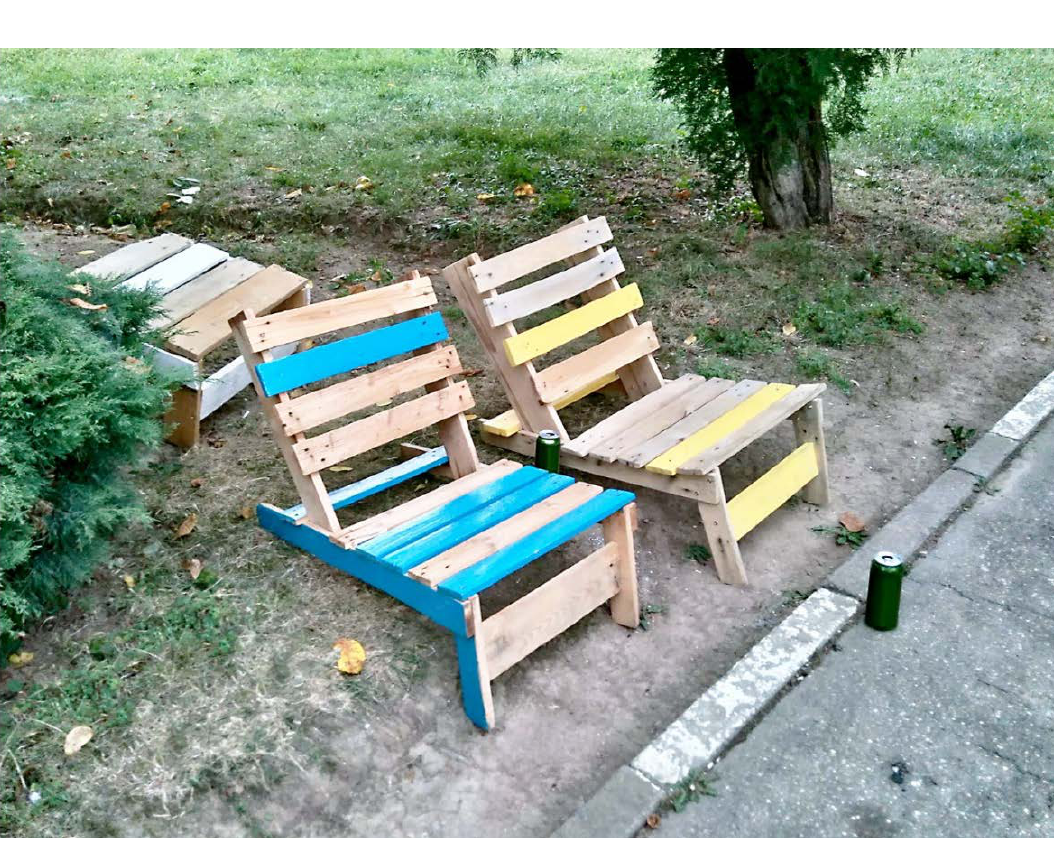
Figure 16: After the